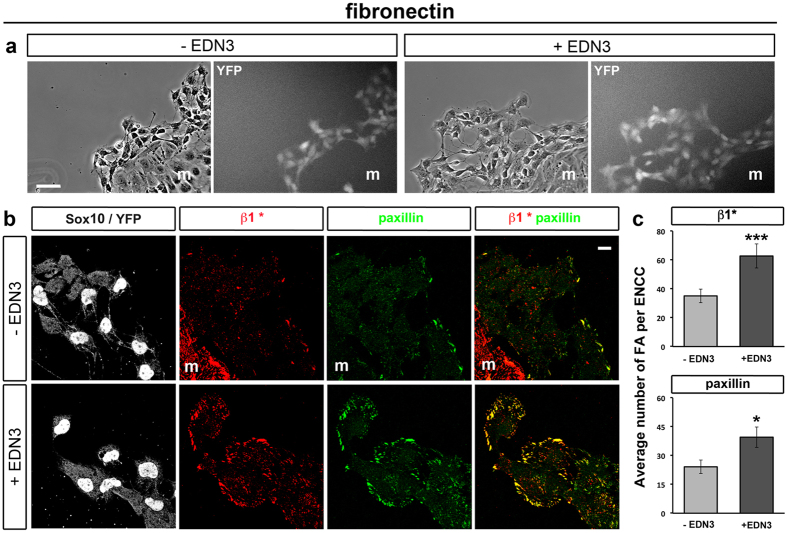
Effect of EDN3 on ENCC adhesion.(a) Phase contrast (left panels) and YFP images (right panels) of control E12.5 gut explants cultured 24 h on FN with or without EDN3. (b) Confocal images of cultures immunolabeled for Sox10 and YFP (ENCCs, left panels), and for activated β1-integrin (β1*) and paxillin to visualize FAs. When present the letter m refers to mesenchymal cells (Sox10−/YFP−), which exit the explant together with ENCCs. Merged images for β1* and paxillin are shown in the right panels. (c) Average number of β1*- and paxillin-positive FAs per ENCC. The number of cells analysed for β1* staining was n = 508 and 449 and for paxillin staining n = 449 and 310, under control and EDN3 conditions, respectively. Error bars indicate the SEM; *p < 0.05; ***p < 0.001. Scale bar in a and b = 50 and 10 μm, respectively.